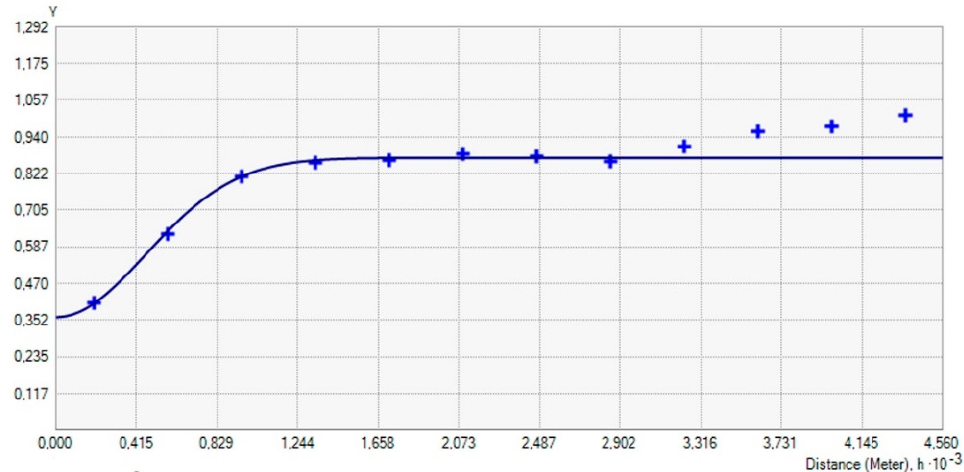
Figure A2. Experimental semivariogram (symbols) and models (line) for total concentration of Pb in the topsoil layer—RMNet.